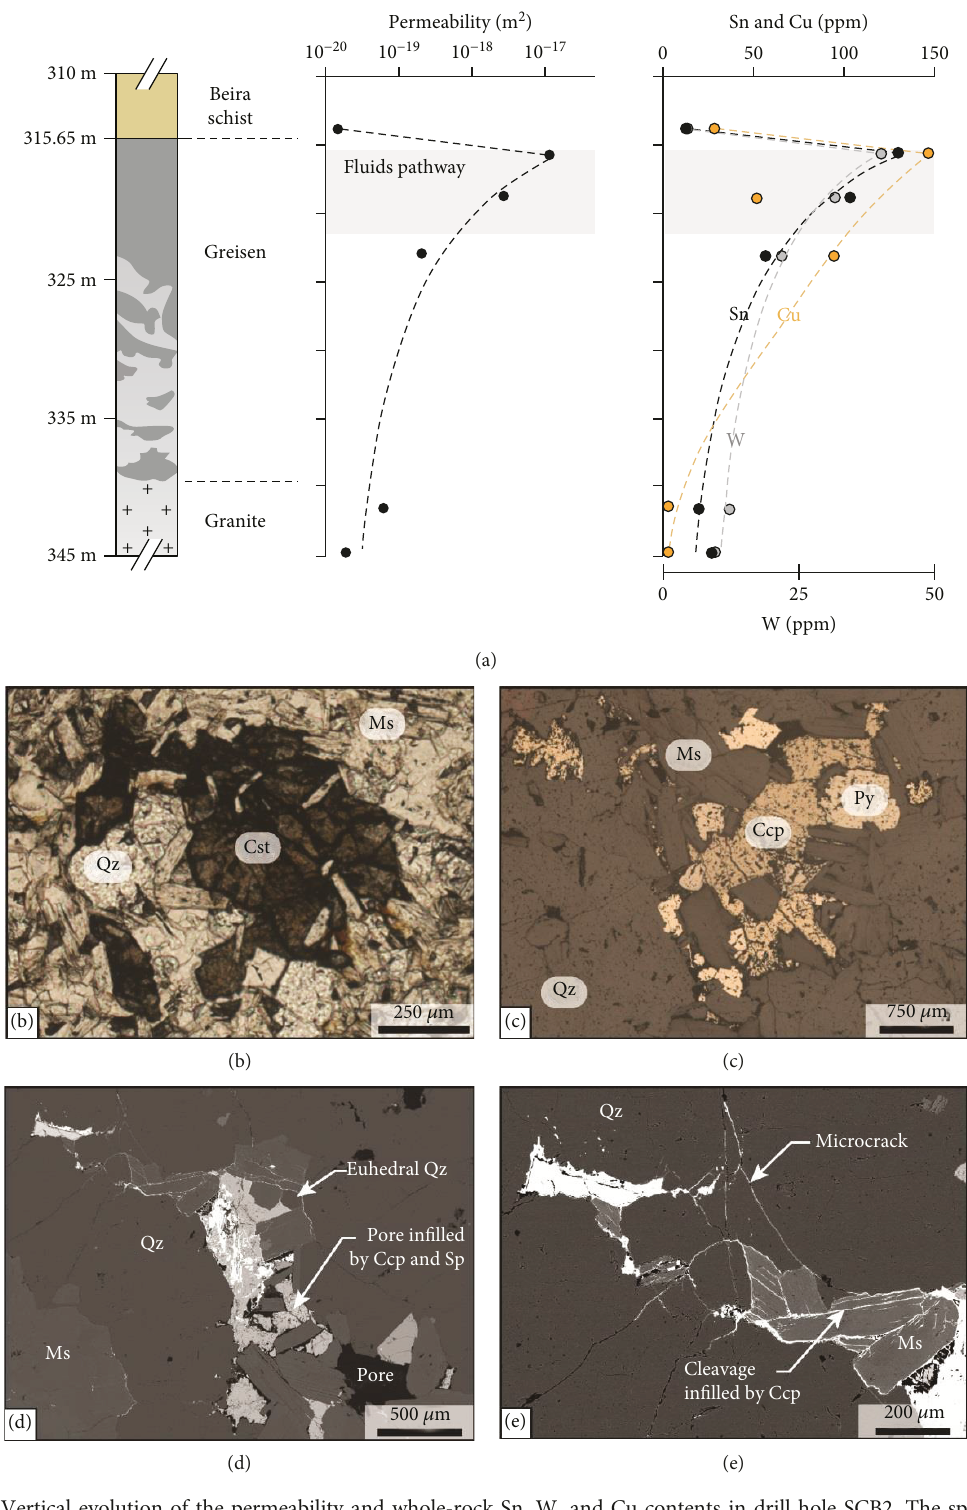
Figure 12: (a) Vertical evolution of the permeability and whole-rock Sn, W, and Cu contents in drill hole SCB2. The spatial correlation between rock permeability and in metal contents suggests that greisen was probably a preferential pathway for fl uids related to the main mineralization stages occurring in the Panasqueira vein system. Greisen pores in fi lled by ore-bearing minerals: (b) cassiterite (transmitted light), (b) chalcopyrite (re fl ected light), and (d-e) chalcopyrite and sphalerite (SEM-BSE images). Note the presence of sul fi des within the cleavage planes of muscovite suggesting that these weakness planes may be potential pathways for fl uids. Abbreviations from Whitney and Evans [45]: Ccp: chalcopyrite; Cst: cassiterite; Ms: muscovite; Py: pyrite; Qz: quartz; Sp: